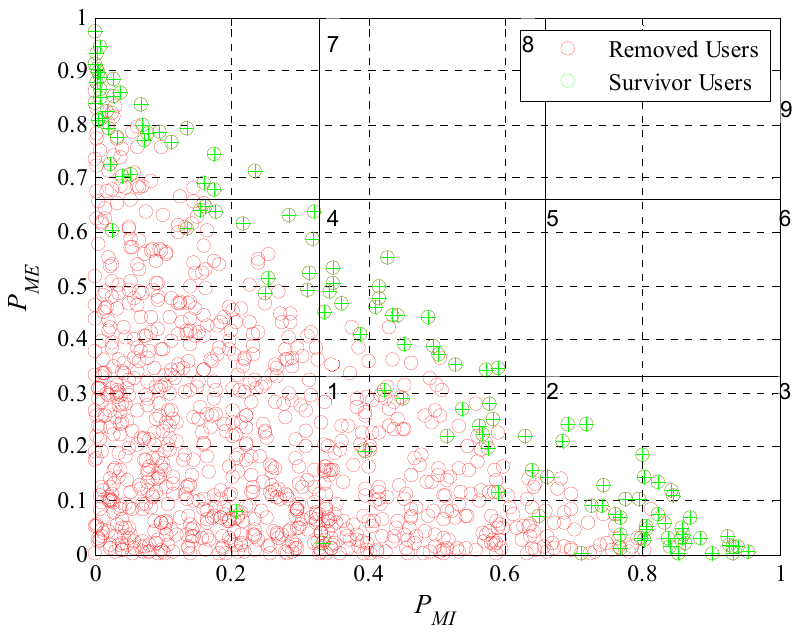
Figure 22. Graphical representation of user motivation levels on a Cartesian plane divided into subgroups when r desired = 0.9.